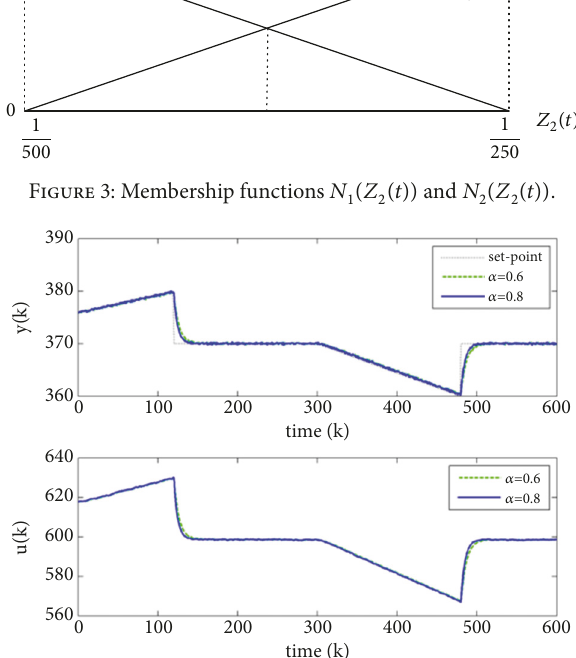
Figure 4: Output response and control input and under constant